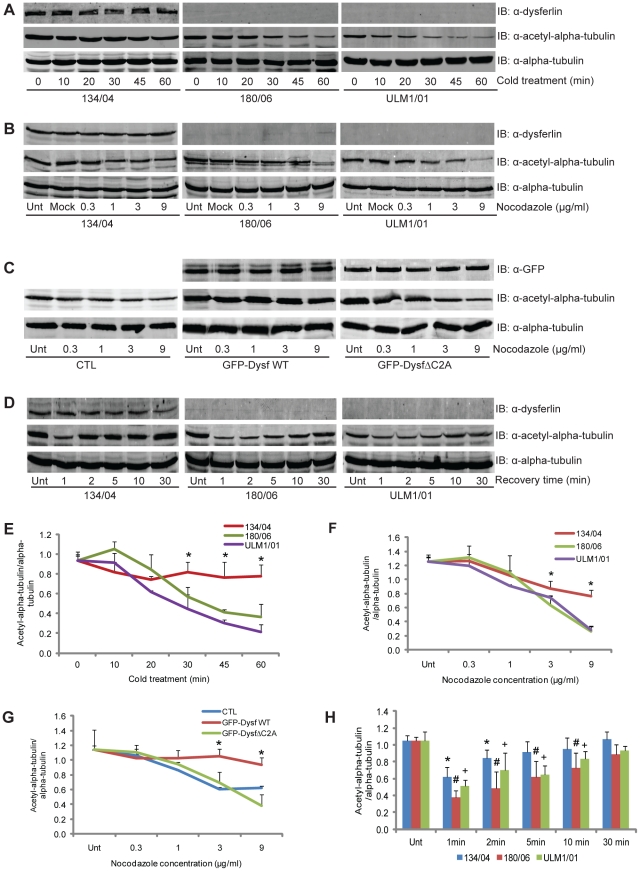
Dysferlin expression increases resistance to microtubule depolymerization.(A) 134/04, 180/06 and ULM1/01 cells were incubated at 4°C for increasing lengths of time. Cell lysates were immunoblotted with the indicated antibodies. To equalize the baseline (0 min) acetylated alpha-tubulin levels in the 180/06 and ULM1/01 cells with those of the 134/04 cells, the intensity of the bands was linearly increased post-acquisition. (B) 134/04, 180/06 and ULM1/01 cells were untreated (Unt), mock-treated (Mock) or treated with increasing concentrations of Nocodazole. Cell lysates were immunoblotted with the indicated antibodies. To equalize the baseline (Unt) acetylated alpha-tubulin levels in the 180/06 and ULM1/01 cells with those of the 134/04 cells, the intensity of the bands was linearly increased post-acquisition. (C) GFP-dysferlin wildtype (GFP-Dysf WT) or GFP-dysferlinΔC2A (GFP-DysfΔC2A) were transfected into HEK293T cells. Transfected and untransfected (CTL) cells were treated with increasing concentrations of Nocodazole. Cell lysates were immunoblotted with the indicated antibodies. (D) 134/04, 180/06 and ULM1/01 cells were untreated (Unt) or treated with 2.5 µg/ml Nocodazole, then the drug-containing media was replaced with fresh media and cells were allowed to recover for the indicated lengths of time. Cell lysates were immunoblotted with the indicated antibodies. To equalize the baseline (Unt) acetylated alpha-tubulin levels in the 180/06 and ULM1/01 cells with those of the 134/04 cells, the intensity of the bands was linearly increased post-acquisition. (E, F, G) The ratio of acetylated alpha-tubulin∶alpha-tubulin at each time point or Nocodazole concentration was normalized to 134/04 levels to equalize starting values. * indicates that 134/04 values or GFP-Dysf WT values were significantly greater (p<0.05) than 180/06 and ULM1/01 levels (E, F) or CTL and ΔC2A levels (G), at the indicated time point or concentration. (H) The ratio of acetylated alpha-tubulin: alpha-tubulin was calculated for each time point and normalized to 134/04 levels to equalize starting values. *, # and+indicate that the value at the indicated time point is significantly different (p<0.05) than the Unt value for 134/04, 180/06, ULM1/01, respectively.